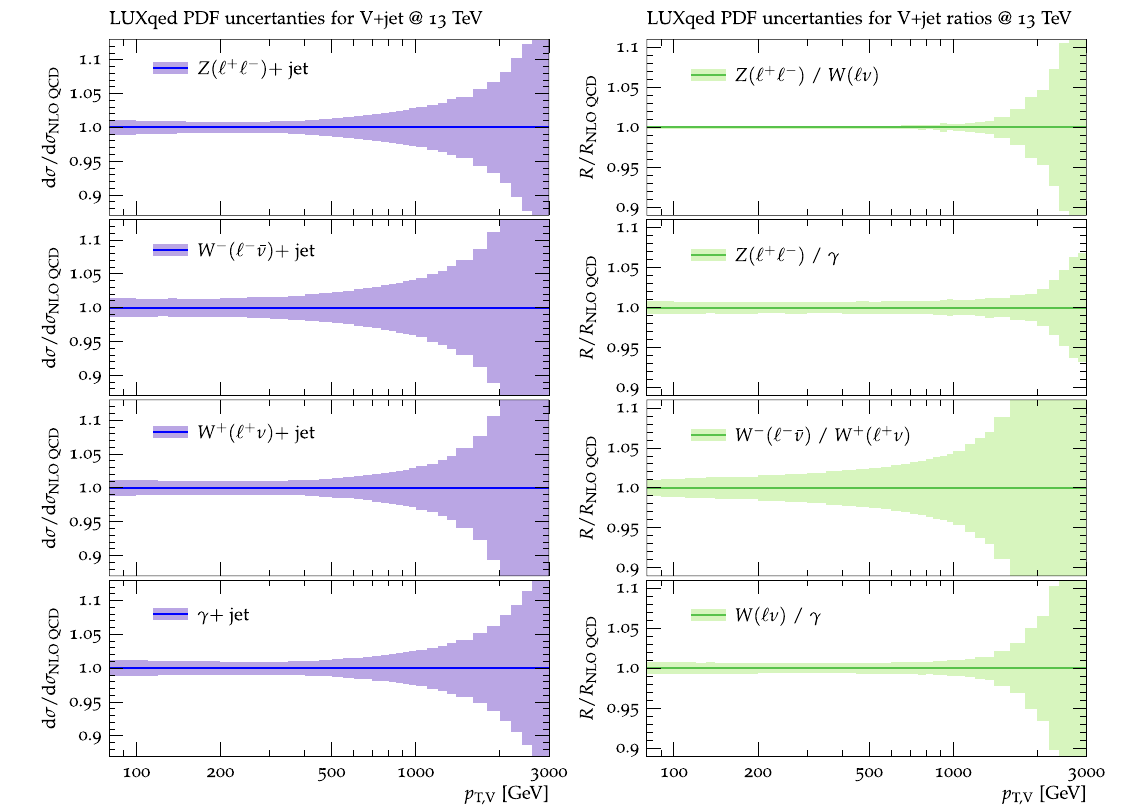
are shown on the right. In the ratios different PDF replicas are corre- lated across processes and the resulting errors on the respective ratio are combined in